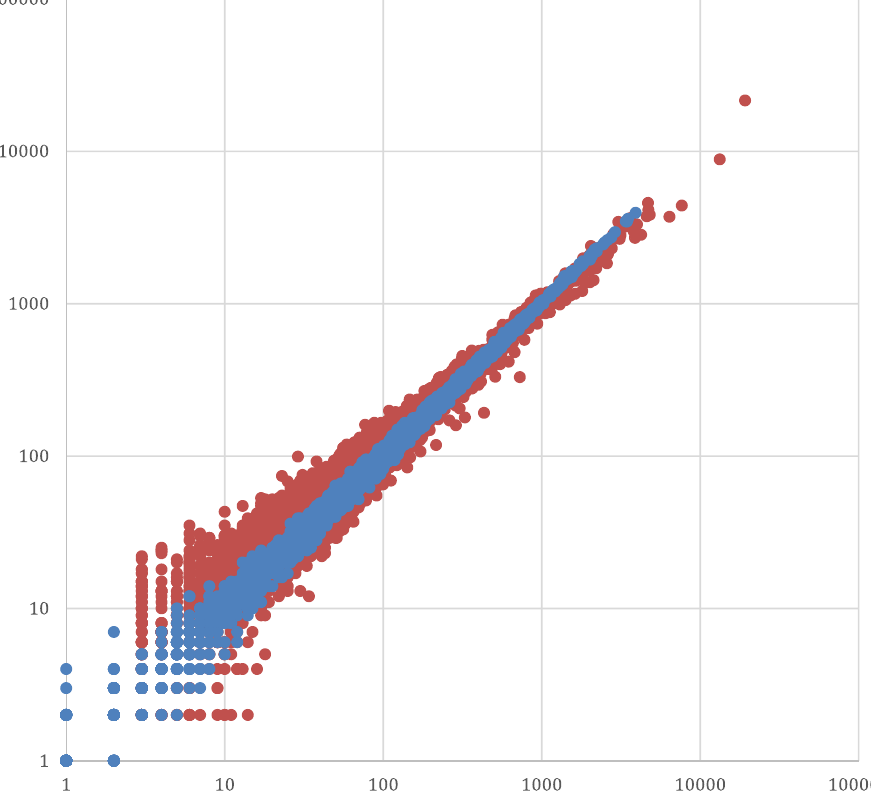
Figure 2. Scatter plot of the number of sequence-reads per gene using TraDIS- Xpress and LoRTIS. Each point on the chart represents a gene. For each gene, the number of sequence-reads mapped in replicate 1 is plotted against the number of reads mapped to the gene in replicate 2. Red points represent the scatter chart of LoRTIS results and blue points that of TraDIS- Xpress results. The strong correlation found indicates the reproducibility of each